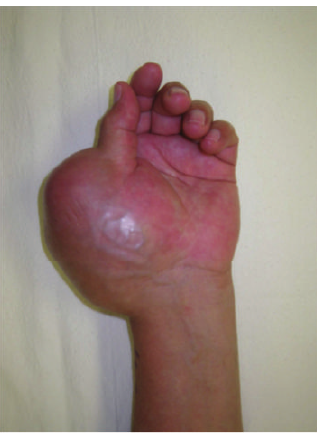
Figure 1: Preoperative photograph of the left hand demonstrating a large thumb mass.